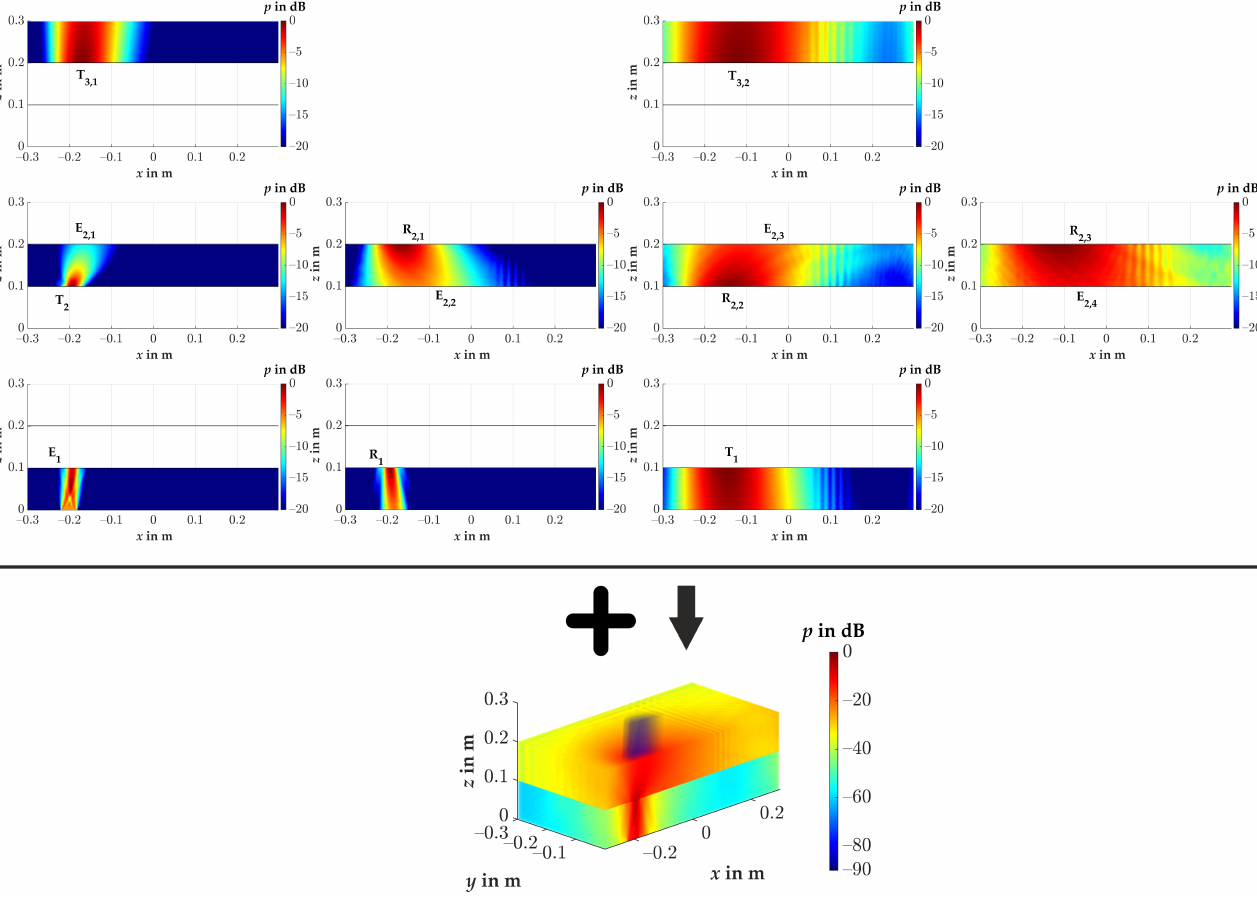
Figure 7. Calculated sound fields in the layered fluids and the superposition of the sound